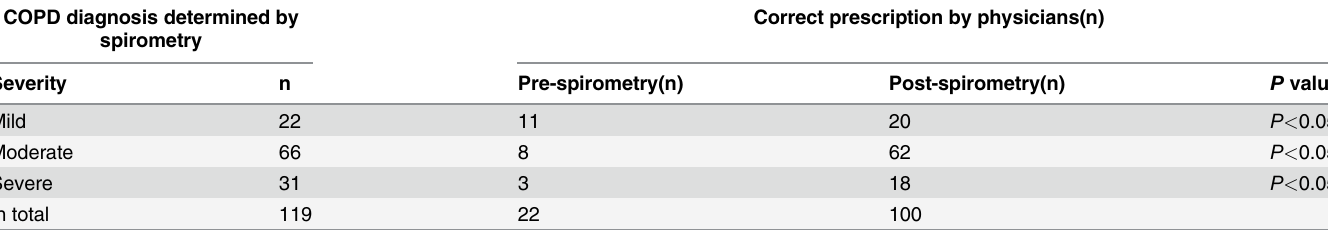
Table 5. Number of correct COPD prescriptions by physicians with or without spirometry. COPD diagnosis determined by